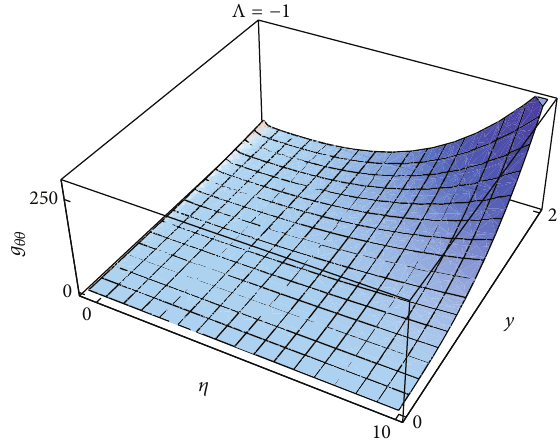
Figure 1: Black string warped horizon 𝑔 𝜃𝜃 (𝑅,𝑦) along the extra dimension for Λ = −1 , for 𝛼 = 1 .